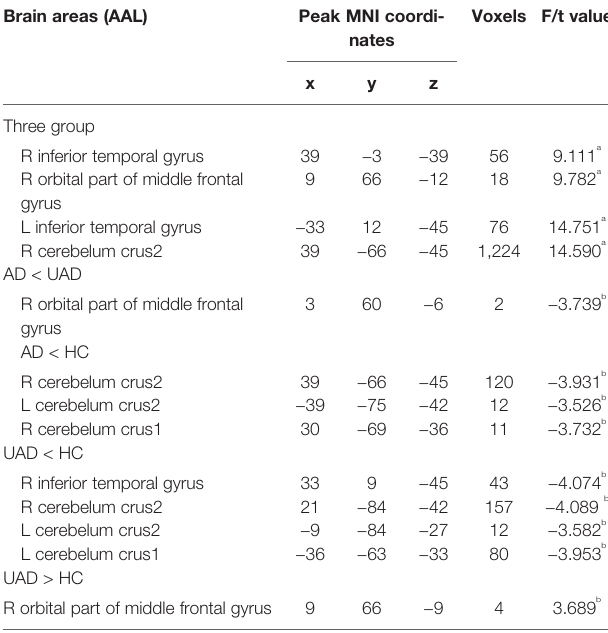
TABLE 2 | Brain areas with amplitude of low-frequency fl uctuation (ALFF) difference among all groups. Brain areas (AAL)